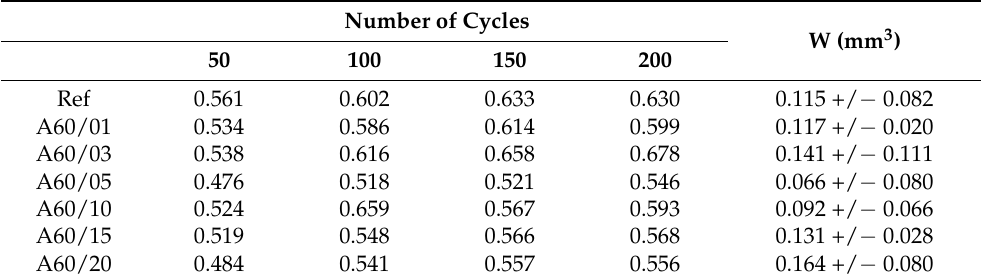
Table 4. COF for brake pads prepared with ELT rubber particles A60 at different brake cycles and the corresponding wear rate values (W) at the end of the experiment.